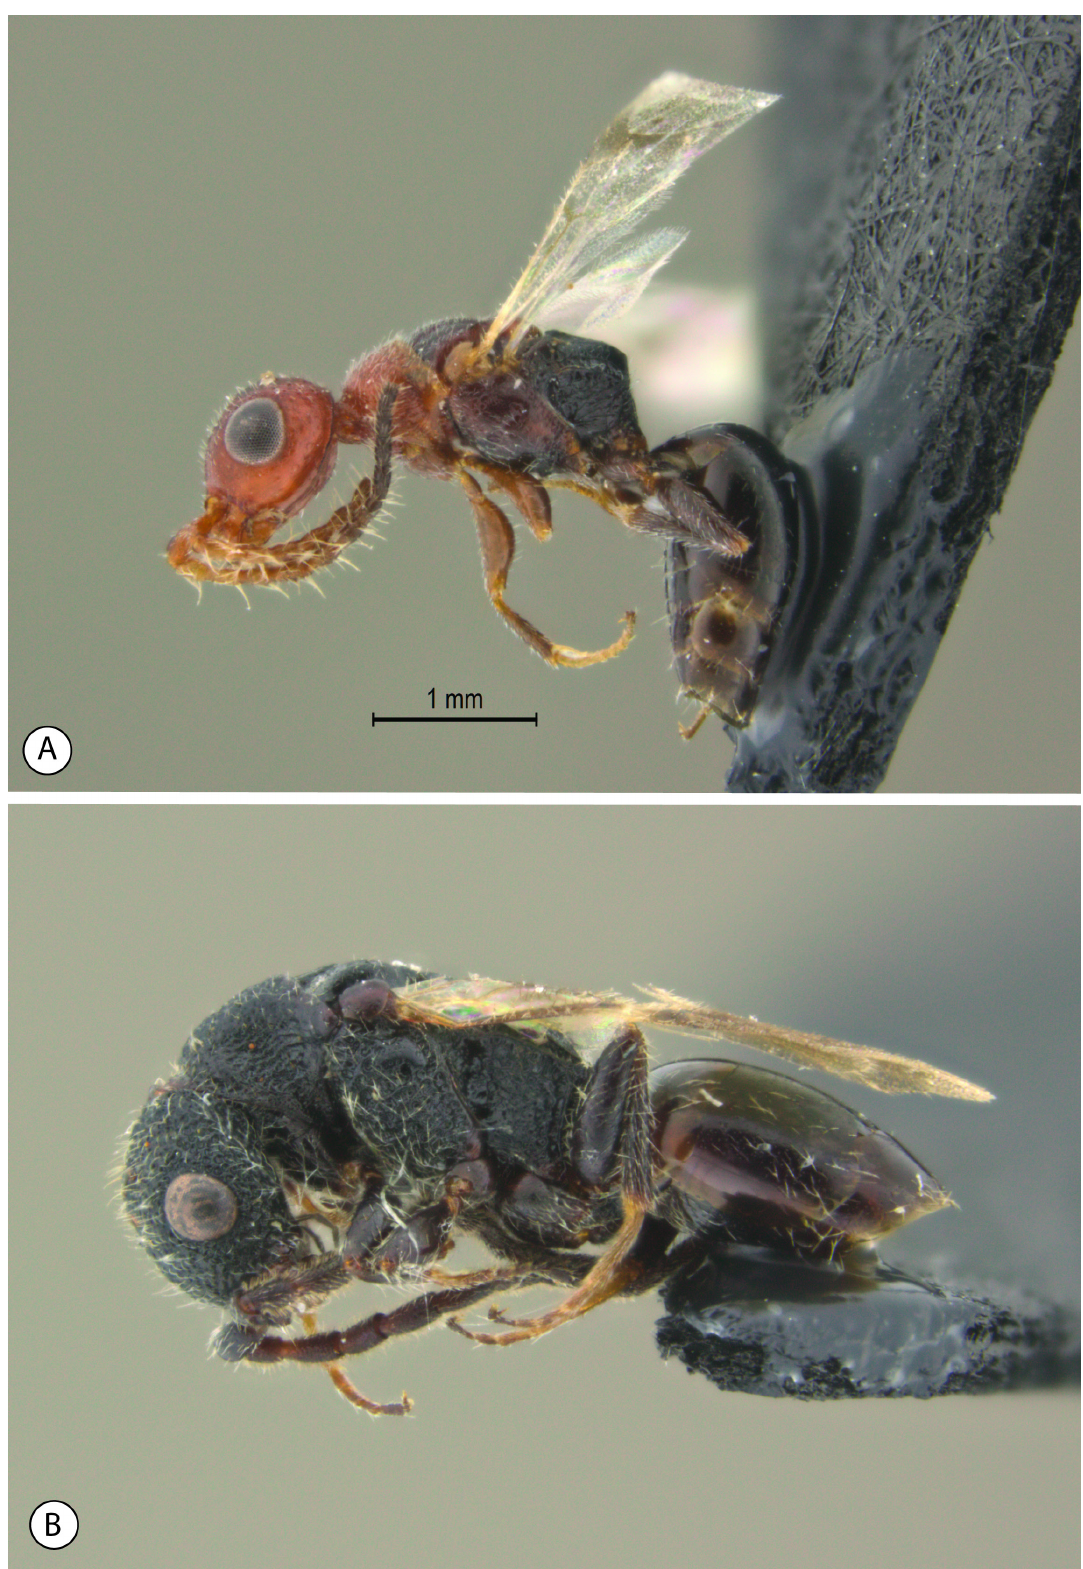
Fig. 7. Habitus of Astromesitius gen. nov. A . A. minutissimus (Móczár, 1971) gen. et comb. nov. (holotype, UFES 56528) B . A. quatei (Móczár, 1977) gen. et comb. nov. (holotype,